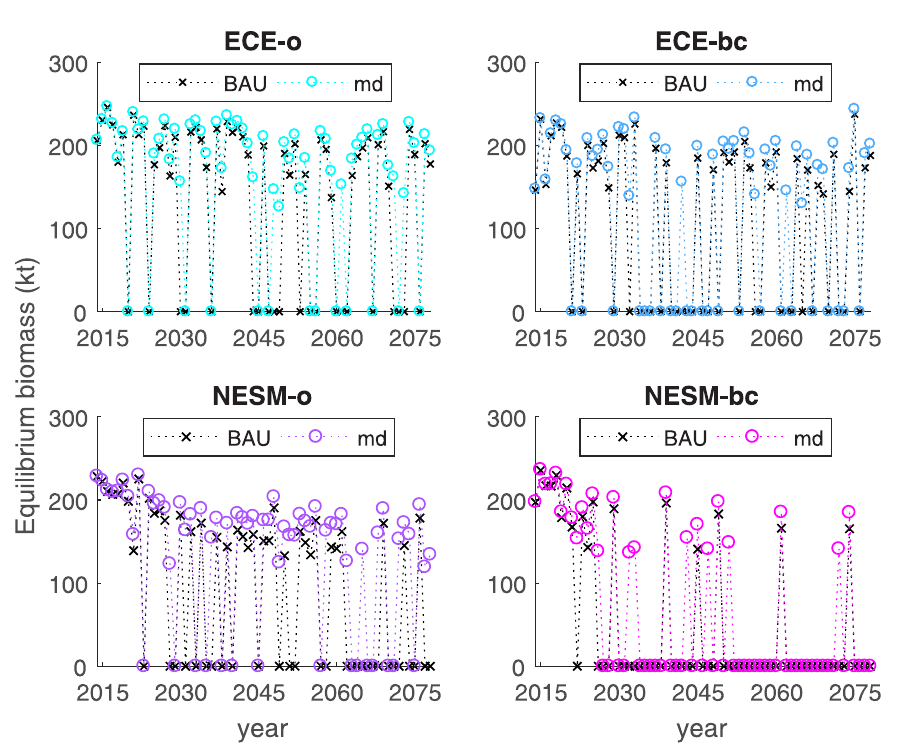
Fig 6. Development of stable equilibrium over time under different climate projections and fuel subsidy scenarios (business as usual, BAU and melt-down, md).